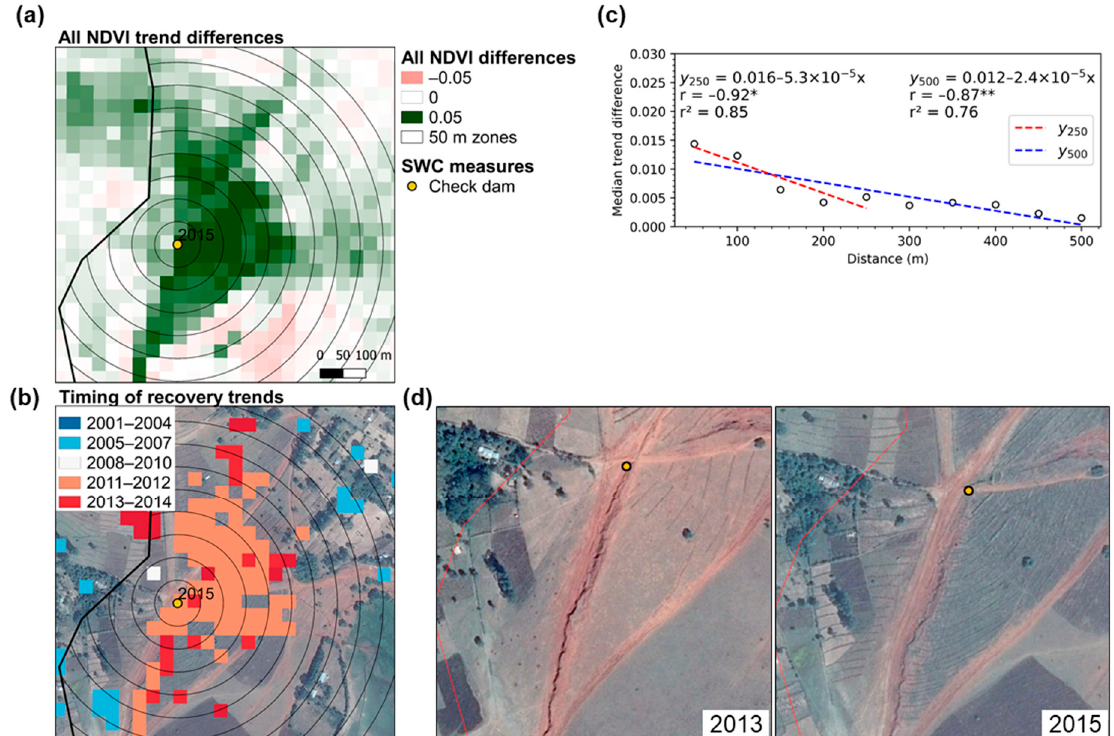
Figure 9. OLS regression of trends at a check dam location in the watershed of Gudeyabila; ( a ) Trend differences (slope of 2011–2018 minus slope of 2002–2010); ( b ) Timing of recovery trends; ( c ) Regression model of the median trend difference for the check dam location; ( d ) Google Earth VHR images showing mainly unterraced hillside in 2013 and the construction of terracing in 2015. * p < 0.05, ** p <